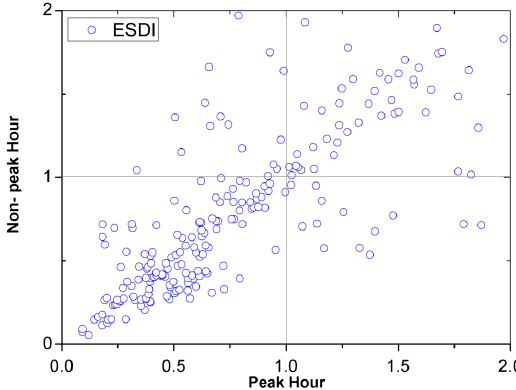
Figure 10. Quadrant spatial distribution of ESDI.